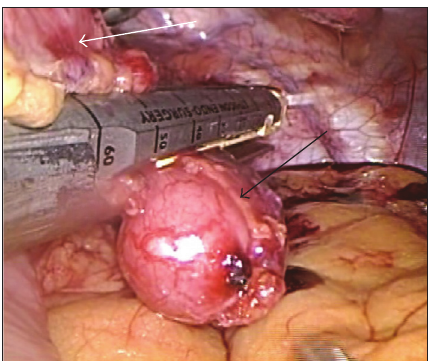
Figure 1: Gross image of the nodule (black arrow) during the surgical procedure. The white arrow points at the serosa of the stomach, from which the nodule was